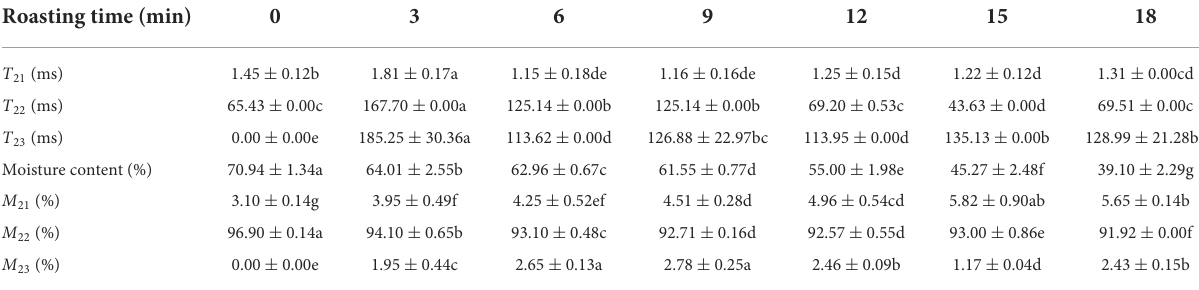
TABLE 3 Effects of moisture content in the materials on the T 2 relaxation time of roasted beef. Roasting time